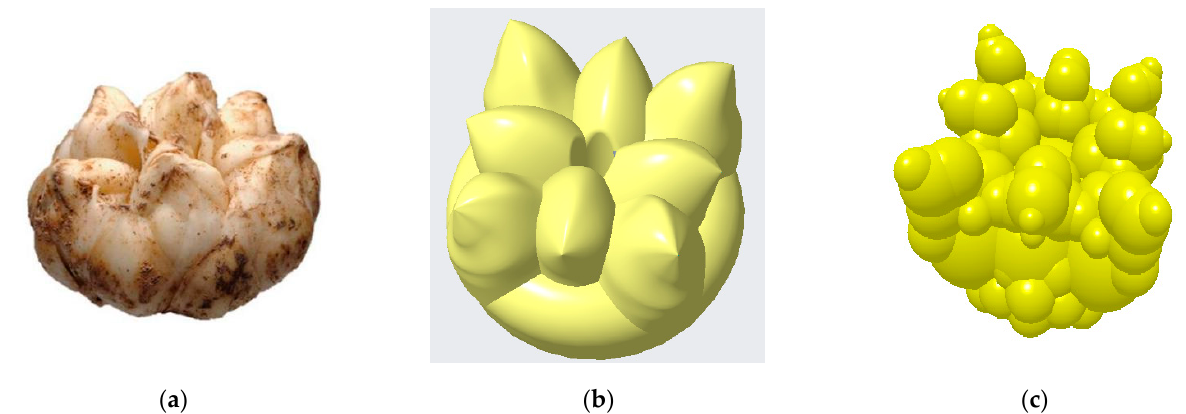
Figure 2. The construction process of lily discrete element model. ( a ) Lily Bulb; ( b ) 3D model; ( c ) Discrete Element Model.